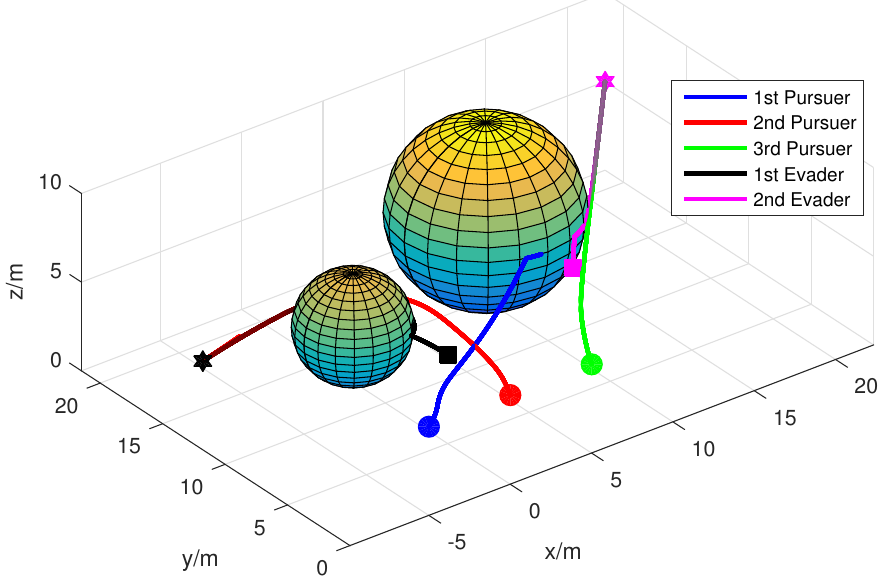
Figure 2. The space trajectories of multi-player PE games.